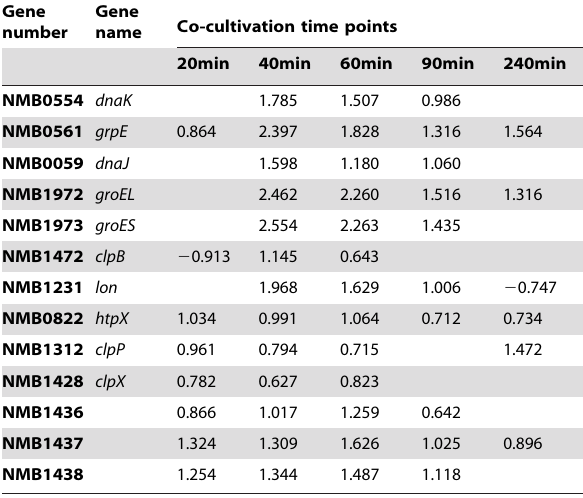
Table 5. Differentially expressed meningococcal genes encoding stress response proteins during blood co-cultivation compared with T=0min samples (log 2 ratio, p , 0.01 with